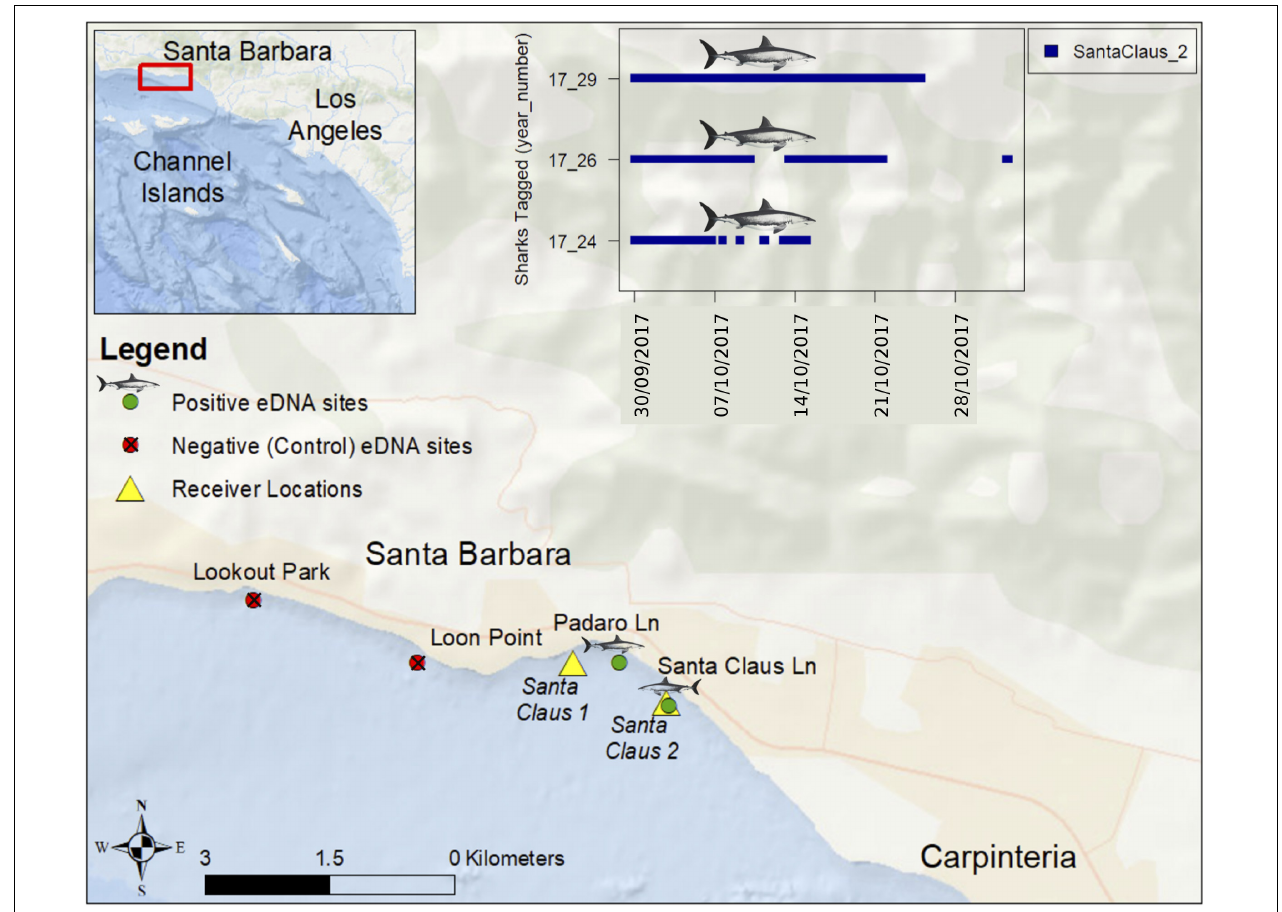
FIGURE 1 | Sites near Carpinteria, California where we detected and failed to detect white shark eDNA on October 25, 2017. Six juvenile white sharks were tagged on August 24, 2017 with external acoustic transmitters at Padaro Lane and two acoustic receivers were deployed on September 29, 2017 as part of a long-term monitoring program. The inset figure shows blue vertical hash marks at times and dates when three tagged juvenile white sharks were detected at the Santa Claus 2 acoustic receiver location (Lowe et al.,